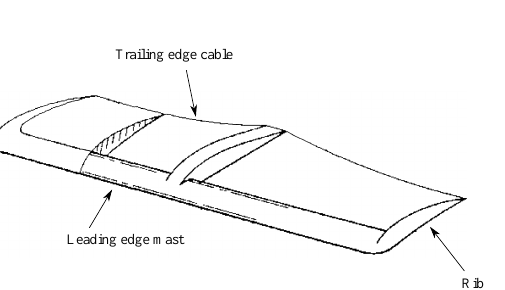
Figure 2. Sailwing construction concept from Ormiston (1971).